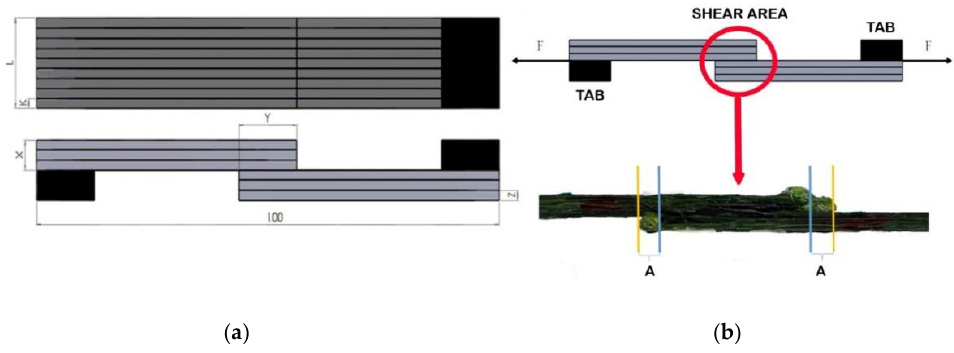
Figure 3. Schematic view ( a ) of the specimen and ( b ) of the tensile test and shear area. All printed samples were grouped according to the number of lines in their